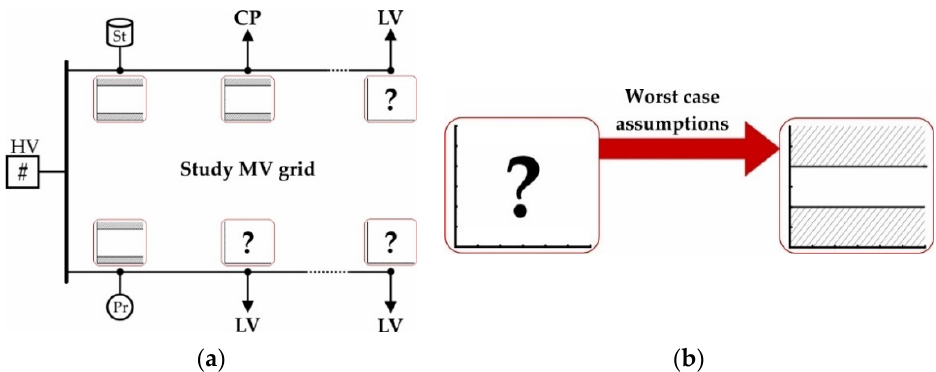
Figure 3. Voltage limits at the MV level conventionally used to verify limit compliance in MV and LV level: ( a ) overview of known and unknown limits; ( b ) estimation of the unknown limits.